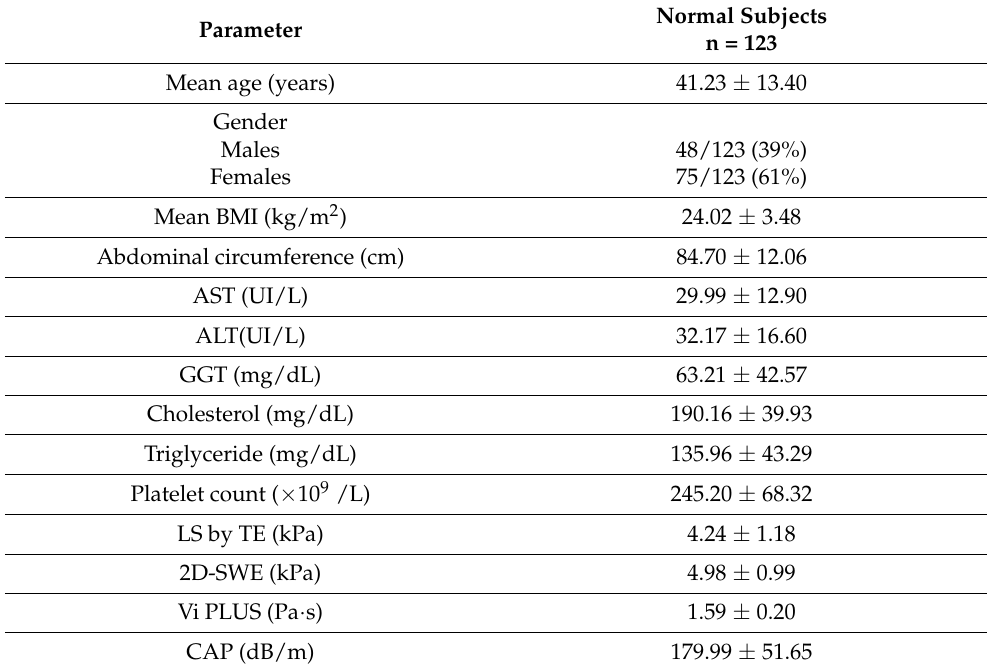
Table 1. Table 1. Characteristics of subjects with reliable